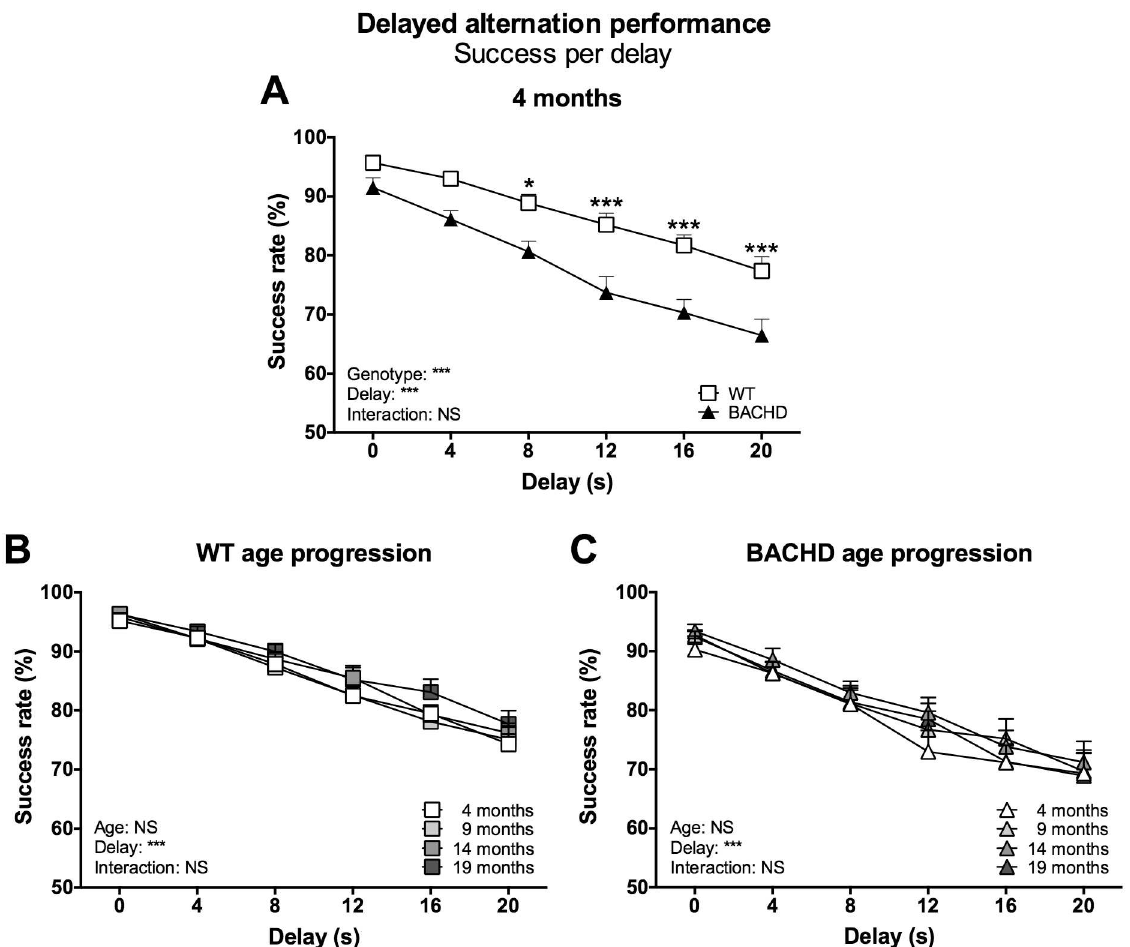
Fig 4. Success rate per delay in the delayed alternation test. The graphs show the success rate on trials preceded by delays of different durationsin the delayedalternation test. (A) shows the stable baselineperformanceof rats maintained on the standard food restriction protocol at four months of age. (B) and (C) show the age progression of performance for WT and BACHD rats. Curves displaygroup mean plus standard error. Results from two-way repeated measures ANOVA are shown inside the graphs. For (A), results from post-hoc analysisare indicatedin case significantgenotypedifferenceswere found. * ( P < 0.05) ** ( P < 0.01) *** ( P < 0.001).